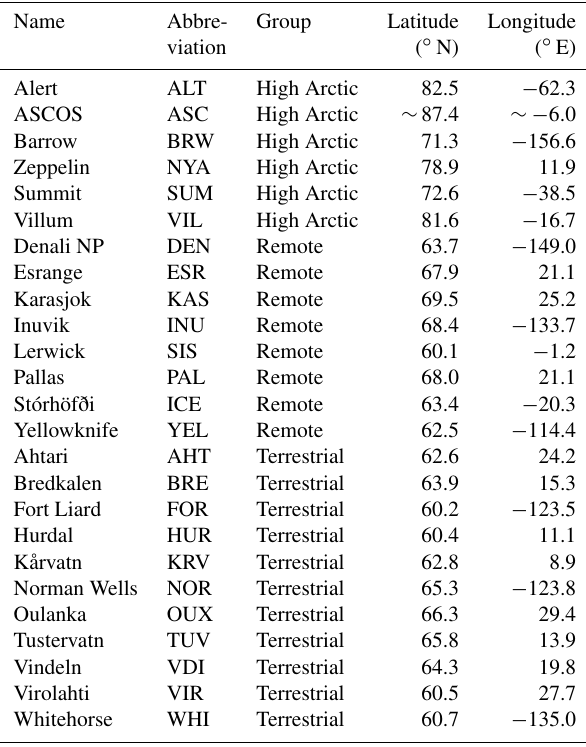
Table D1. Surface ozone measurement sites subdivided in the“High Arctic”, “Remote” and “Terrestrial” site